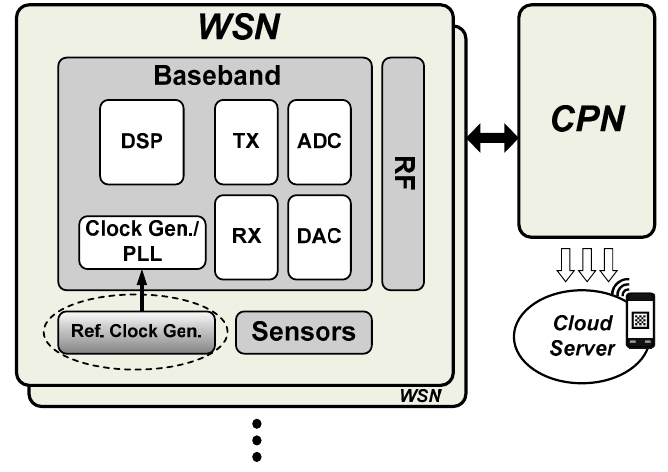
Figure 1. A typical wireless body area network (WBAN) system.